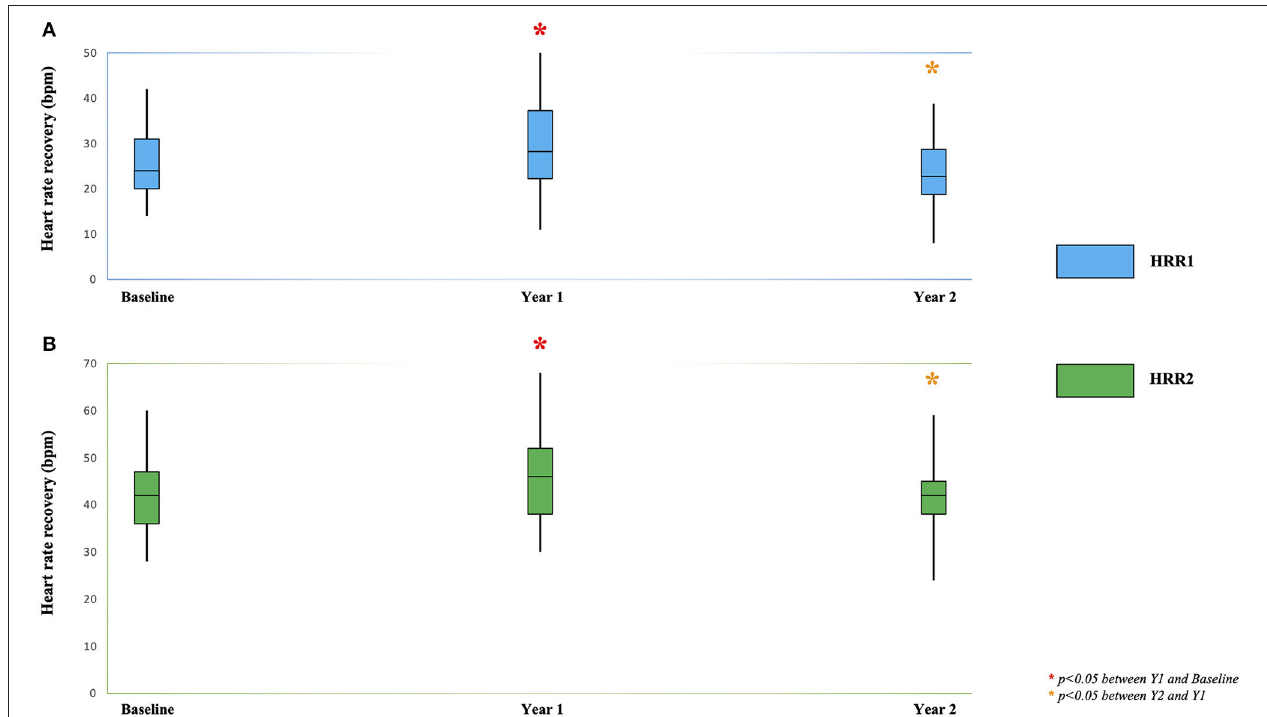
FIGURE 1 | Heart rate recovery at 1 min: HRR1 (A) and 2 min: HRR2 (B) during the 2-year physical activity program in participants with RA. ANOVA on ranks analysis was conducted to determine statistically significant changes during the 2-year study protocol. * p < 0.05 between Y1 and Baseline. * p < 0.05 between Y2 and